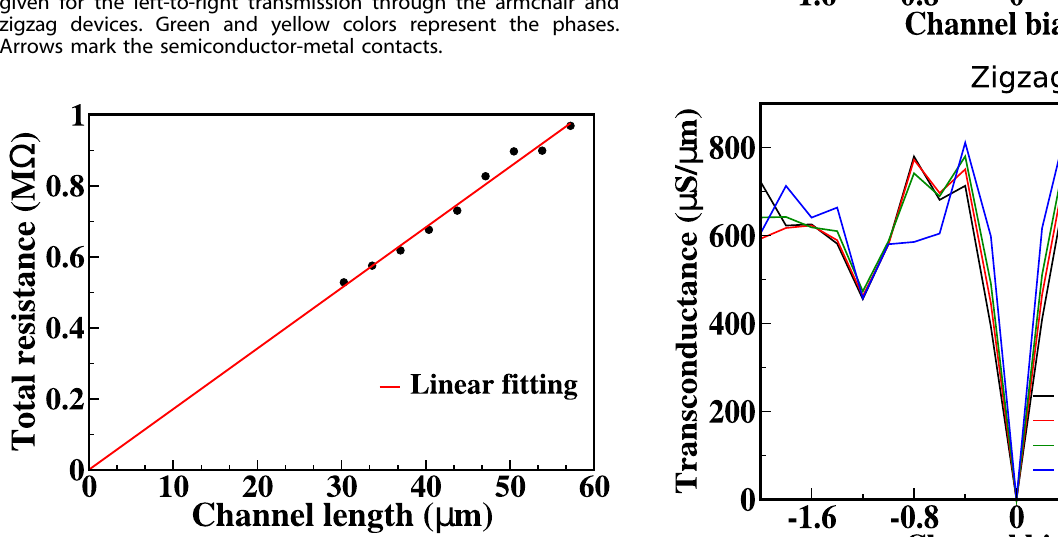
Fig. 4 Total resistance as a function of the channel length. The data refer to the zigzag device. Fig. 5 Transconductances as functions of the channel bias. Results are given for transport along the armchair and zigzag